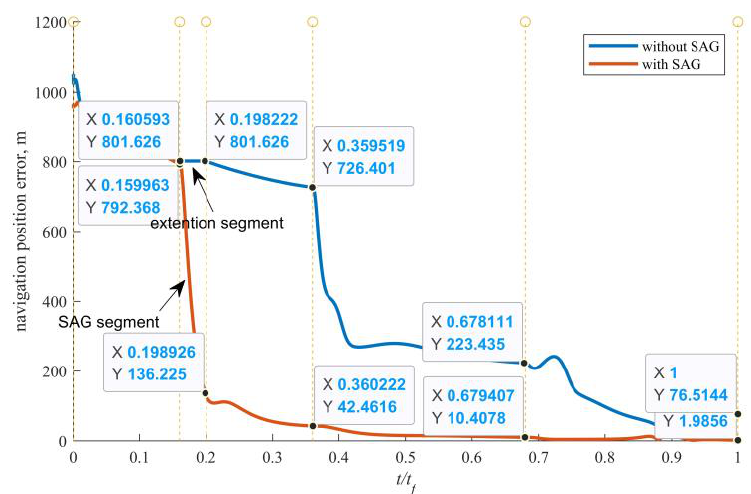
Figure 10. AON position error with and without SaG.